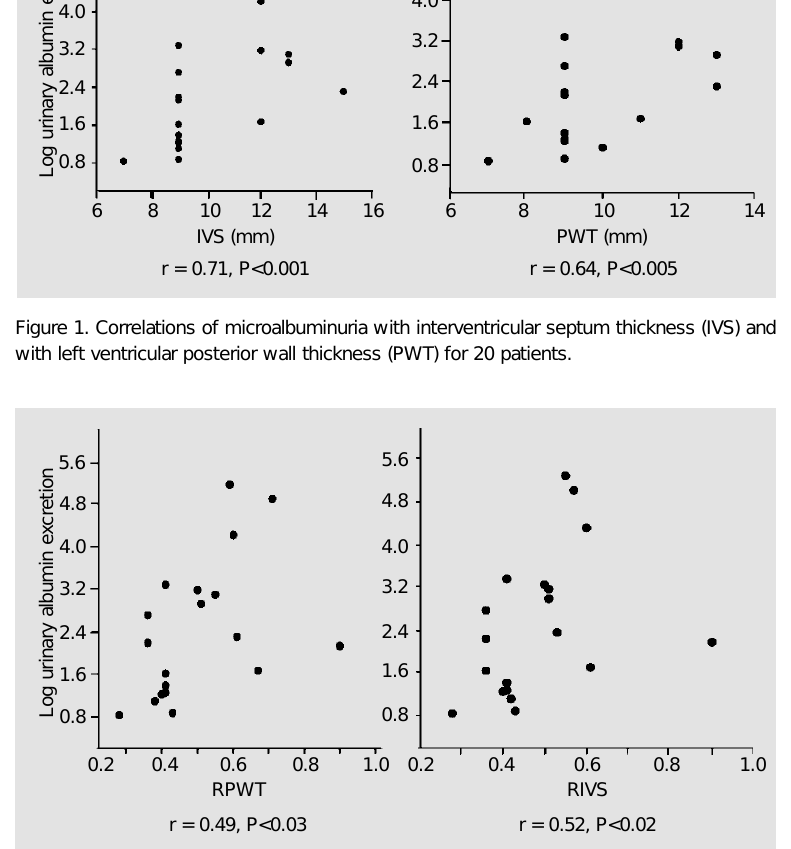
Figure 2. Correlations of microalbuminuria with relative left ventricular wall thickness (RPWT) and with relative interventricular septum thickness (RIVS) for 20 patients.